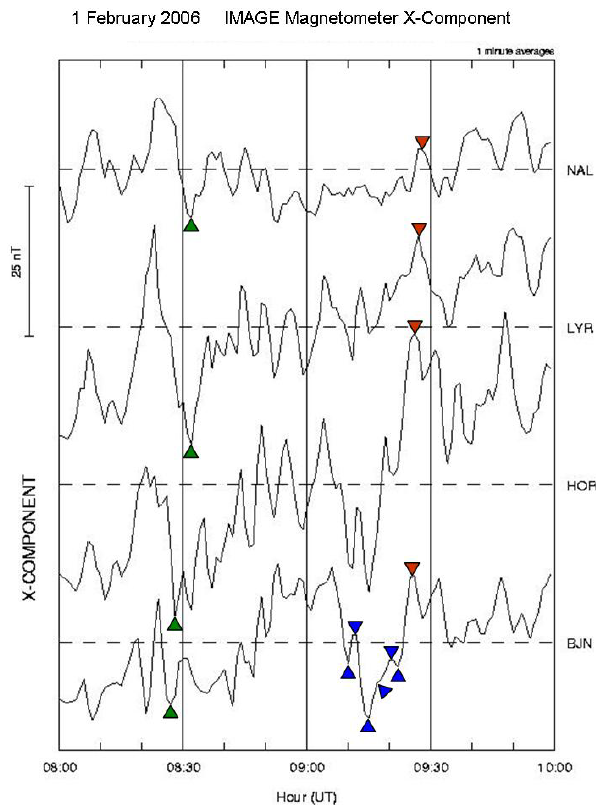
Fig. 10. Magnetogram for the X-component at 4 different sta- tions from 08:00UT to 10:00UT: Bjørnøya (BJN, 71.57 ◦ N CGM), Hornsund (HOR, 74.26 ◦ N CGM), Longyearbyen (LYR, 75.38 ◦ N CGM) and Ny ˚Alesund (NAL, 76.32 ◦ N CGM). Green triangles correspond to southward turning of IMF, blue triangles correspond to reconnection time of injected ions and red triangles show pole- ward propagation during the ongoing